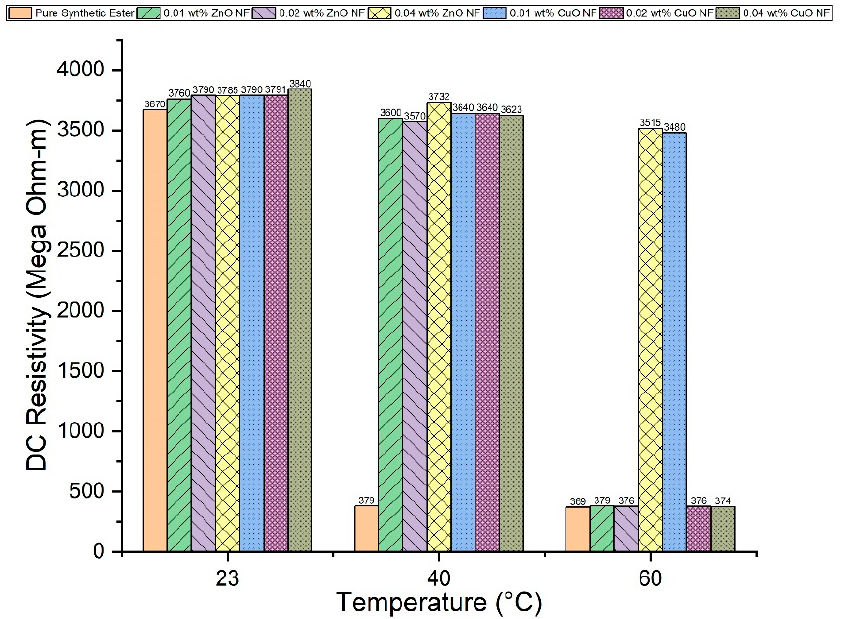
Figure 7. The DC Resistivity Vs. Temperature plot for nanofluids and pure oil.